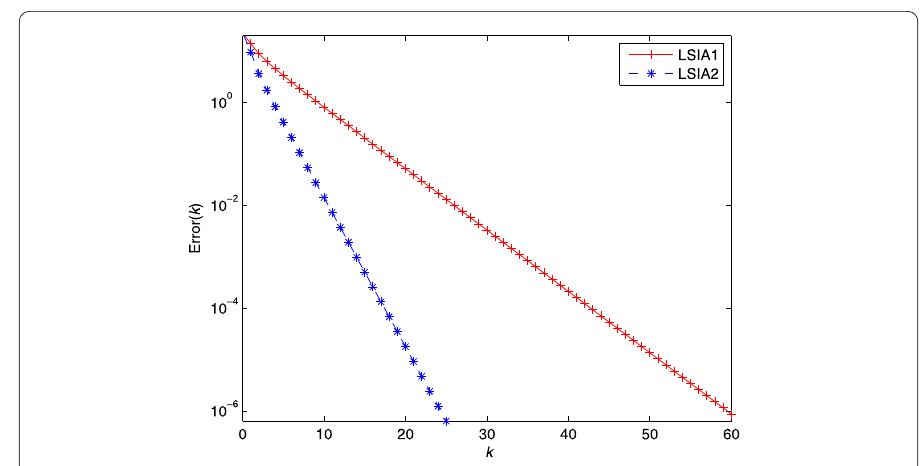
Figure 2 Numerical results of the two tested algorithms (LSIA1 and